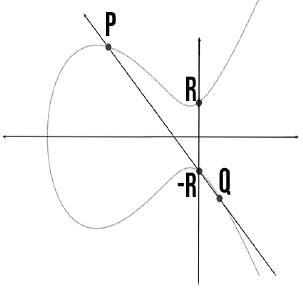
Figure 3. Point addition on ECC.